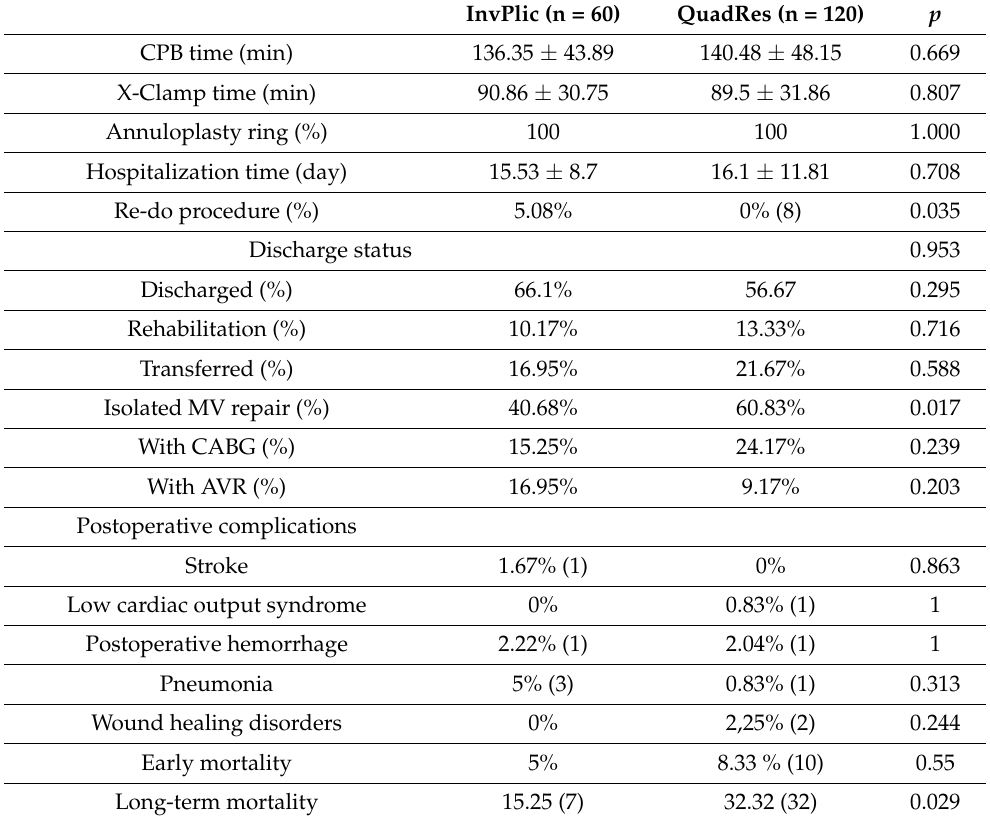
Table 2. Outcome and